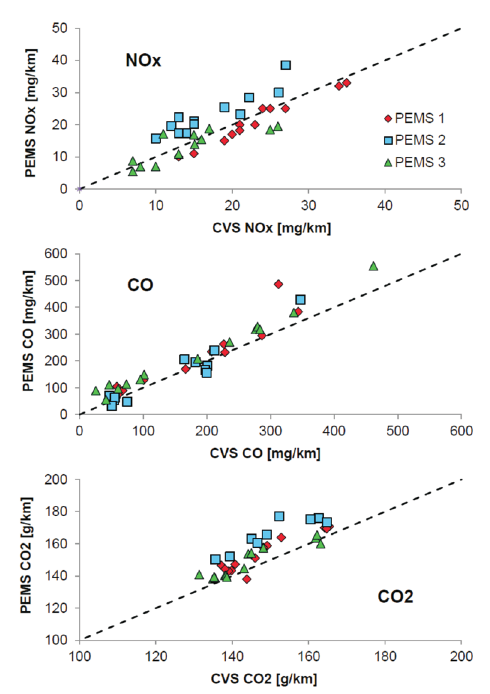
Fig. 5. Correlations of emissions measured with PEMS and with station - ary CVS-installation in all investigated driving cycles: NEDC cold, NEDC, WLTC, CADC